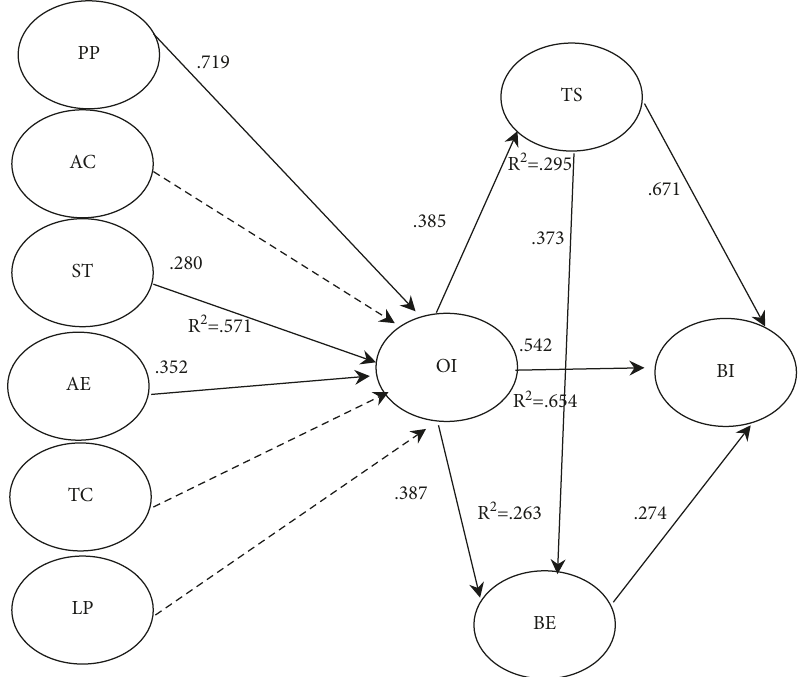
Figure 3: Corrected theoretical model. Note . The solid line indicates significant; the dotted line indicates not